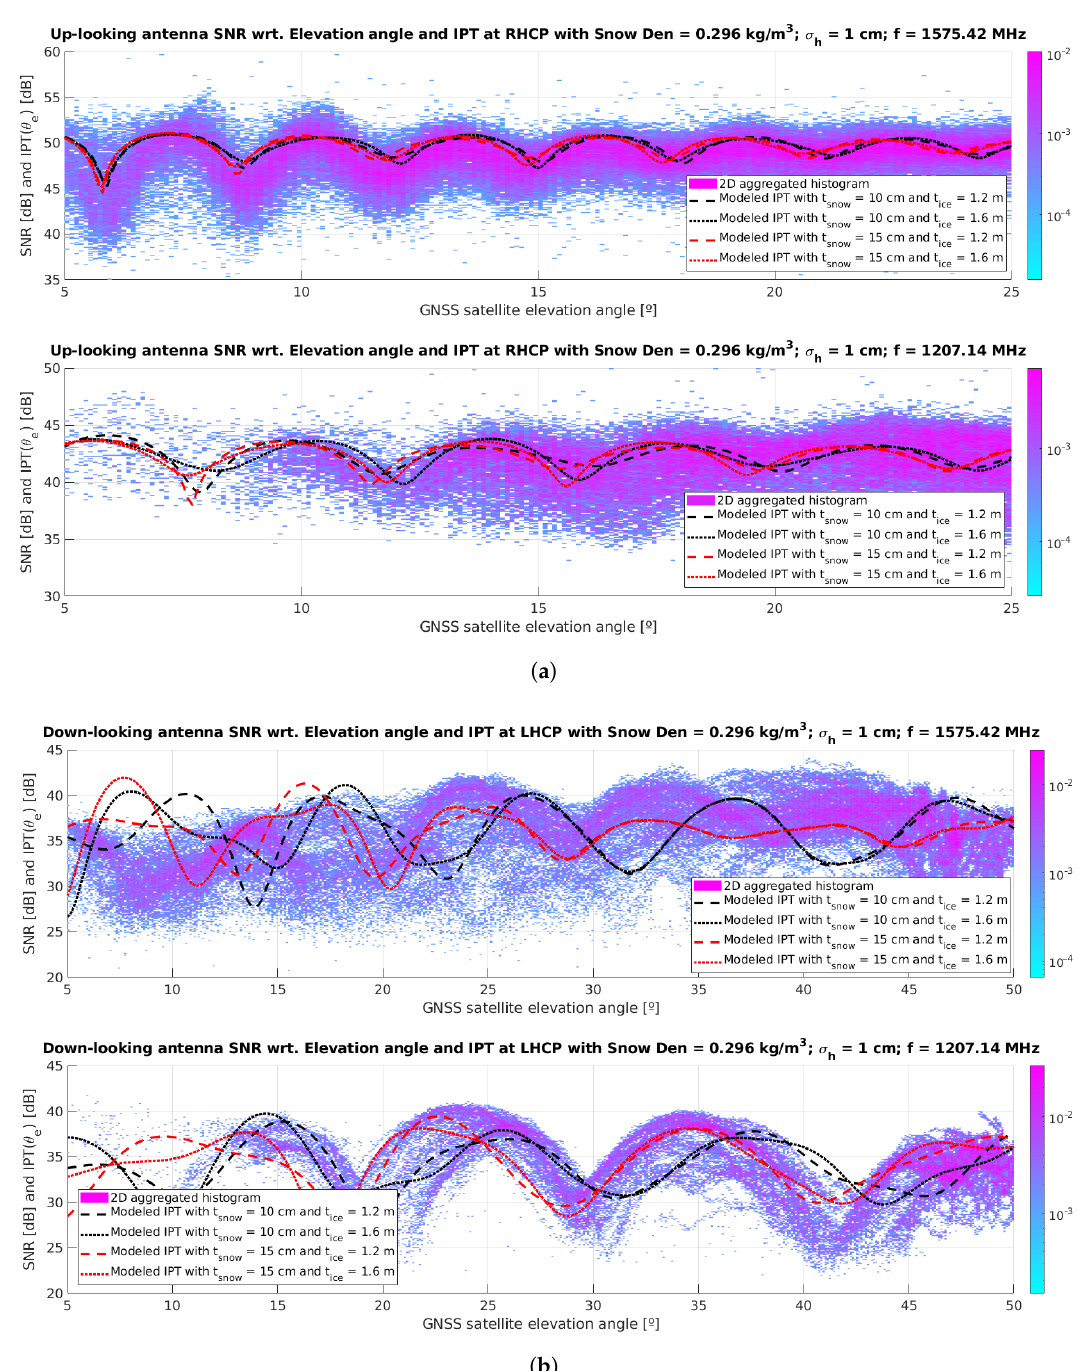
Figure 10. Aggregated 2D histogram (density plot) for the up-looking RHCP signal SNR for both 1575.42 MHZ and 1207.14 MHz; and IPT for RHCP ( a ) and LHCP ( b ) signal for different snow and ice thickness.